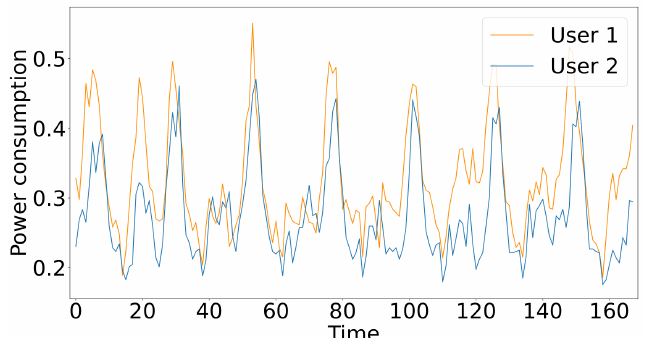
Figure 4. Consumer electricity consumption per hour.